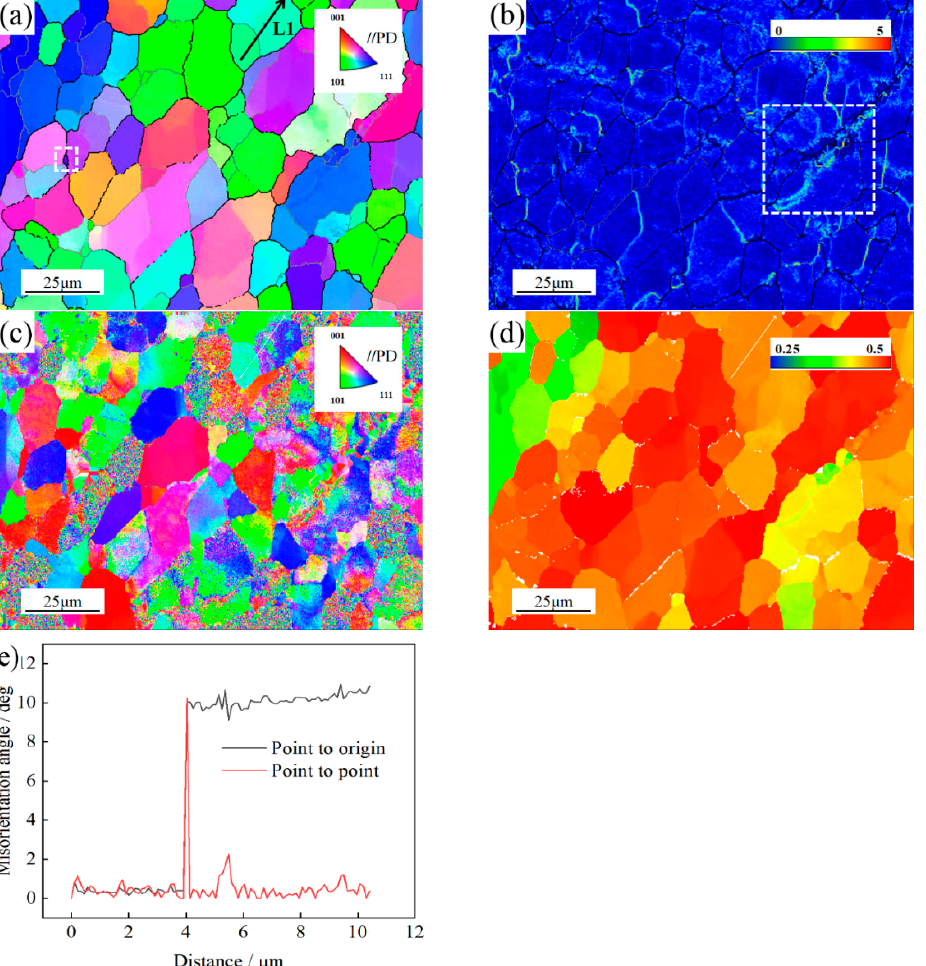
Figure 12. Maps in the SZ-2 of ( a ) IPF; ( b ) KAM; ( c ) GROD axis; ( d ) SF and ( e ) misorientation profiles obtained along the lines marked in Figure 12a: L1.